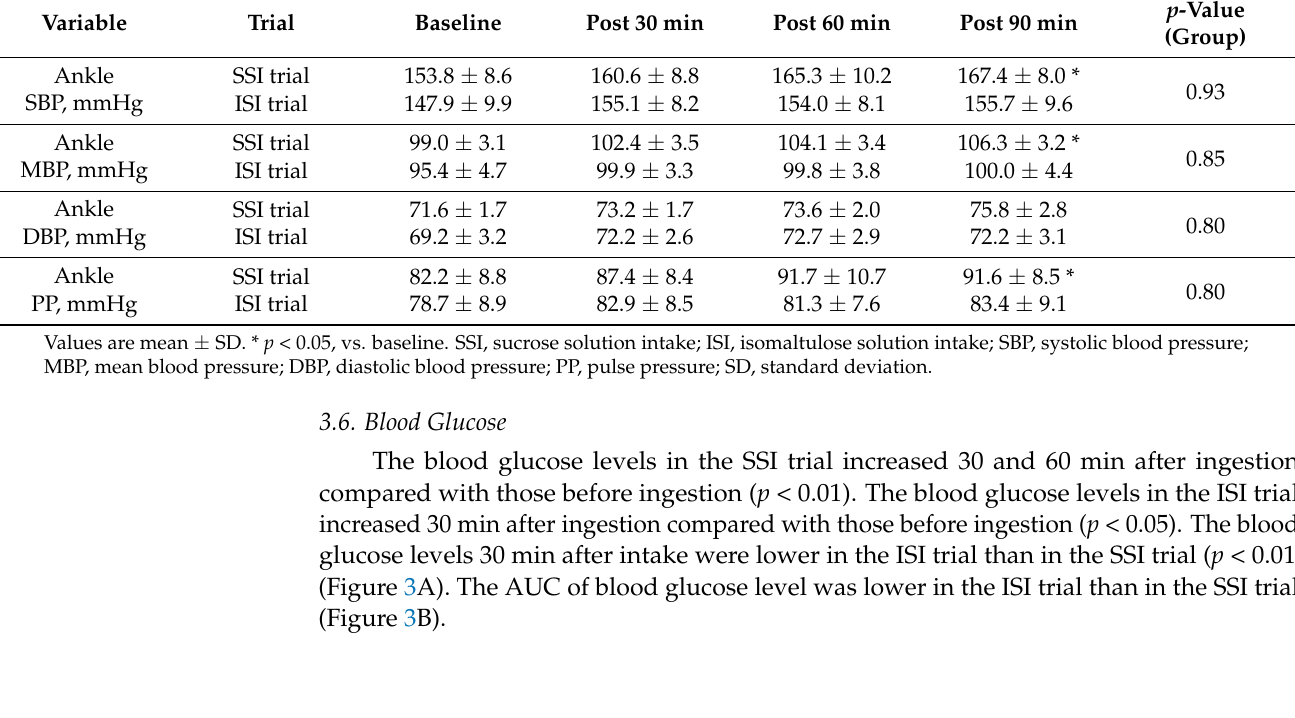
Table 3. Changes in ankle SBP, MBP, and DBP before and after the ingestion of isomaltulose and sucrose.